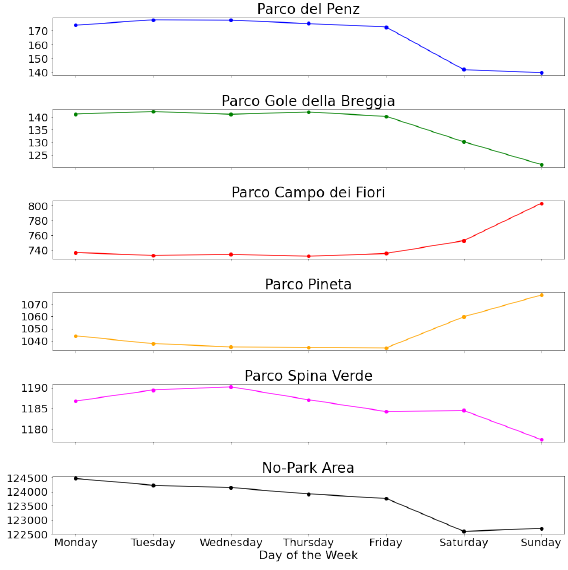
Figure 3. Variation of Facebook mean users’ population count per day of the